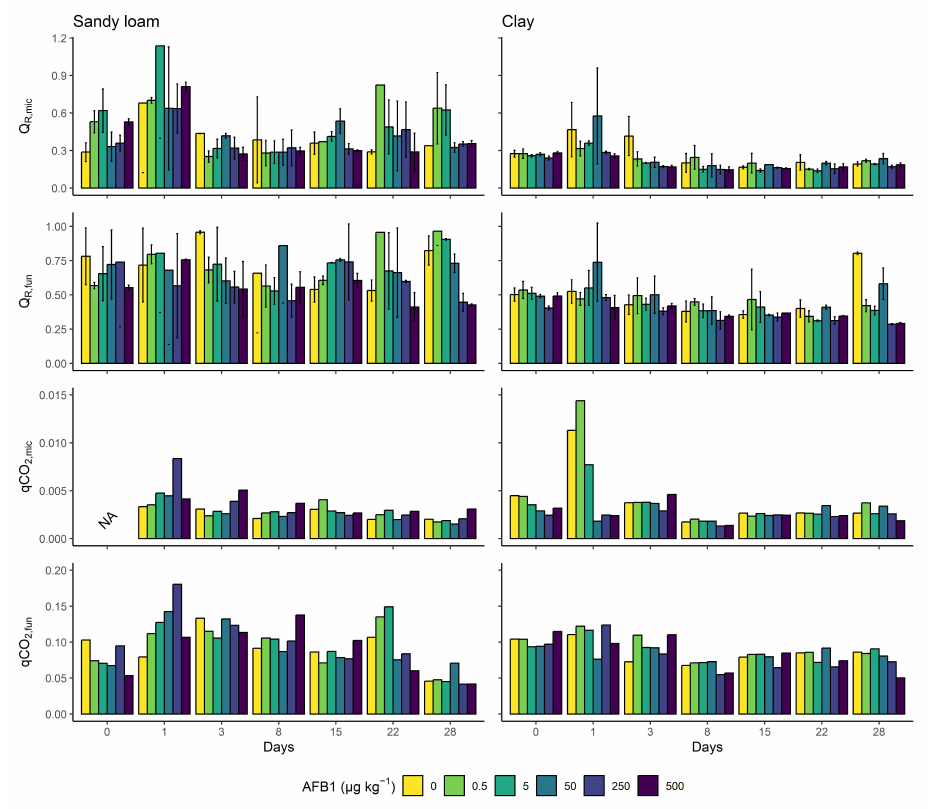
Figure A6. Ecophysiological ratios: Microbial basal-to-substrate induced respiration (Q R,mic ), fungal basal-to-substrate induced respiration (Q R,fun ), microbial metabolic quotient (qCO 2,mic ), and fungal metabolic quotient (qCO 2,fun